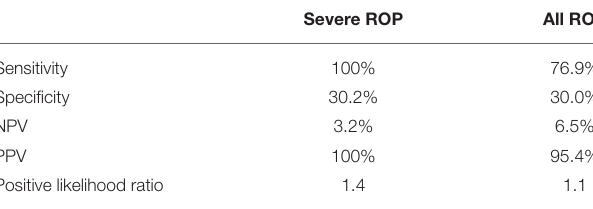
TABLE 2 | WINROP performance in predicting ROP. Severe ROP All